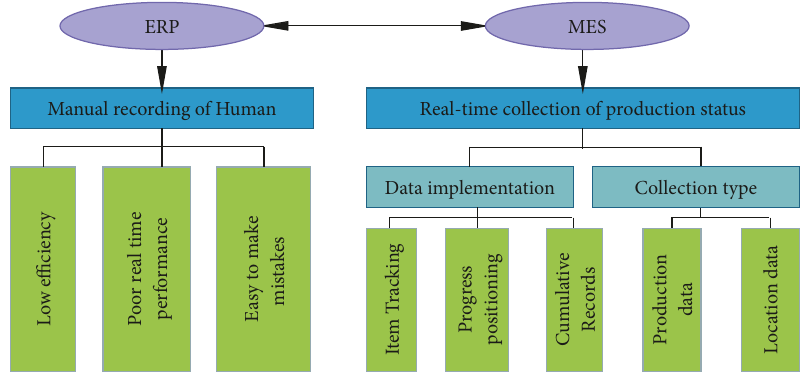
Figure 1: Comparison diagram between ERP system and MES